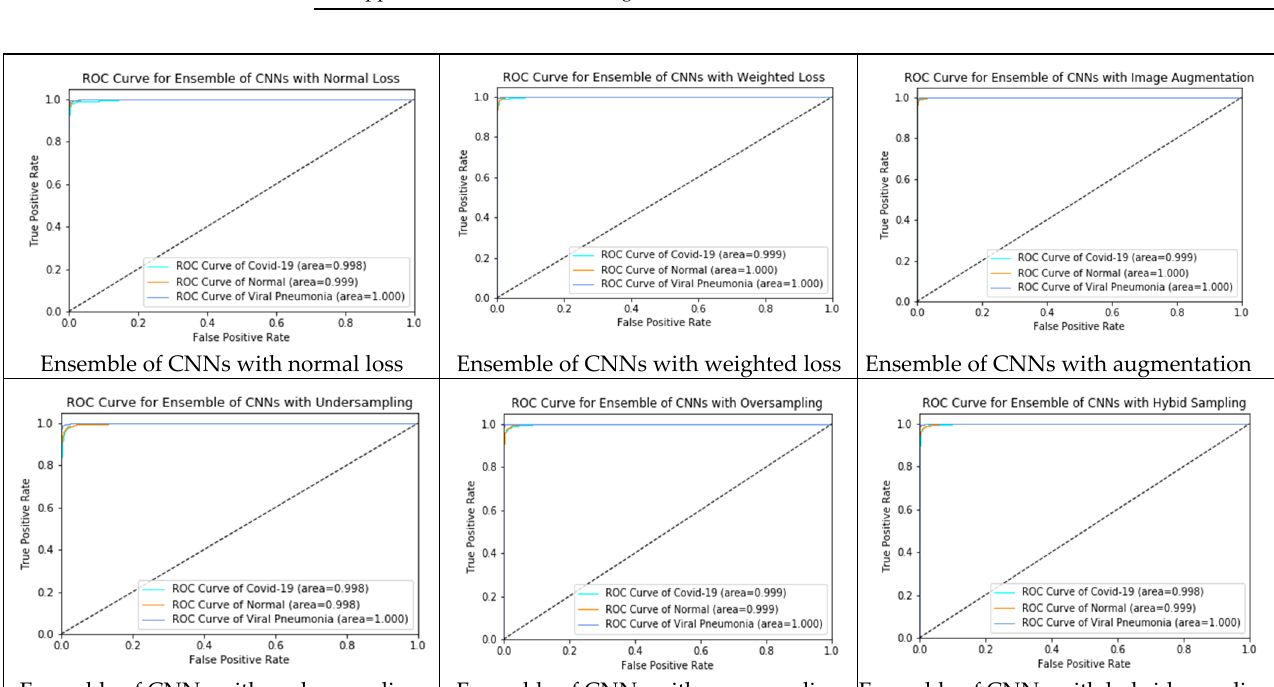
Figure 17. The indicative regions of COVID-19 biomarkers highlighted by DenseNet201. We have compared our proposed methods with previous studies and presented this in Table 12. Most previous studies claimed high performance values; among them, Ben Jabra et al. [20] claimed 99.31% and 100% recall. However, the common theme among them is the use of a dataset with a limited number of COVID-19 images, which was the main concern in this research. Moreover, most studies omitted to handle the unbalanced class problem, which can result in biased classifications. Rajaraman et al. [23] proposed an iterative prune method that works well on a limited number of images and achieved 99.01% accuracy; however, those methods cannot guarantee the production of similar re- sults for larger datasets. Bridge et al. [24] proposed GEV-based deep learning to remedy unbalanced class distribution; however, their proposed method obtained an AUC of 71%, which is significantly low. In this study, we proposed alternative approaches to tackle unbalanced data using the largest dataset consisting of 3619 COVID-19 CXRs and achieved an accuracy of 99.23% and an AUC of 99.97%. It is not necessarily best to directly compare with previous studies due to the use of different datasets. Therefore, Table 10